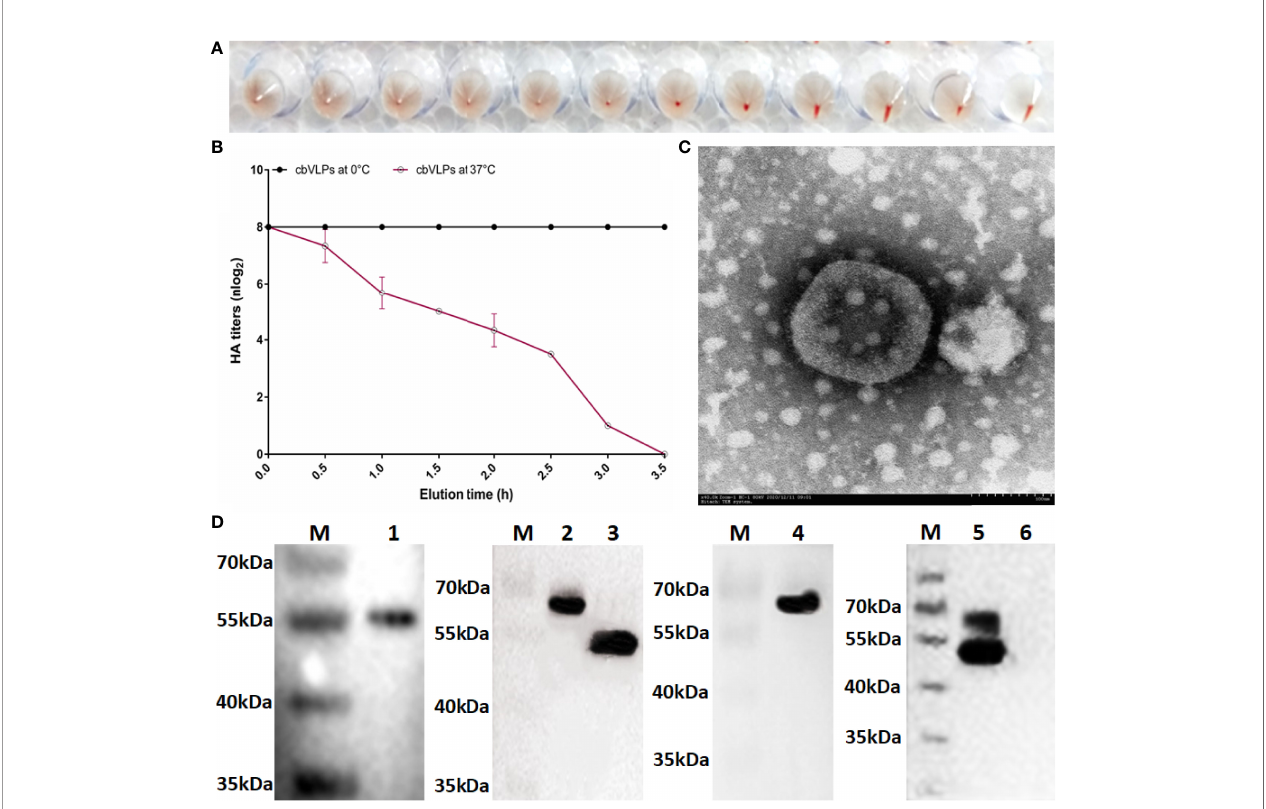
FIGURE 4 | Identi fi cation of cbVLPs. Panel (A) : The hemagglutination activity of cbVLPs. The HA titer of cbVLPs can reach 8log2. Panel (B) : Elution pro fi les of cbVLPs from the adhered chicken red blood cells. In the virus elution assay, 25 m L of cbVLPs with an HA titer of 1:256 was incubated with 25 m L of 1% chicken red blood cells in U-shape microtiter plates at 4°C for 1h. Subsequently, the plates were incubated at 37°C. Reduction of HA titers was recorded. Panel (C) : A near- spherical enveloped cbVLP (diameter ≈ 180nm) with spikes. Scale bar 100nm. Panel (D) : Identi fi cation of the components of cbVLPs by Western blot. Lane M: Protein molecular weight standard; Lane 1: Gag protein detected by Gag antibody; Lane 2: H9 protein detected by H9N2 antibody; Lane 3: N2 protein detected by H9N2 antibody; Lane 4: H3 protein detected by H3N2 antibody; Lane 5: The upper overlapping bands of H9 and H3 and the lower overlapping bands of Gag and N2, which were simultaneously detected by the mixture of antibodies against Gag, H9N2 and H3N2. Line 6: The Sf9 cell suspension as a negative control. The molecular weights of Gag, H9, N2, and H3 were approximately 54kDa, 63kDa, 52kDa, and 63kDa,